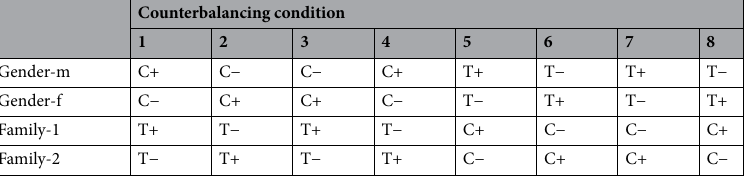
Table 1. The eight appearance-trait mappings trained in Experiment 3. C+ and C− denote high and low competence. T+ and T− denote high and low